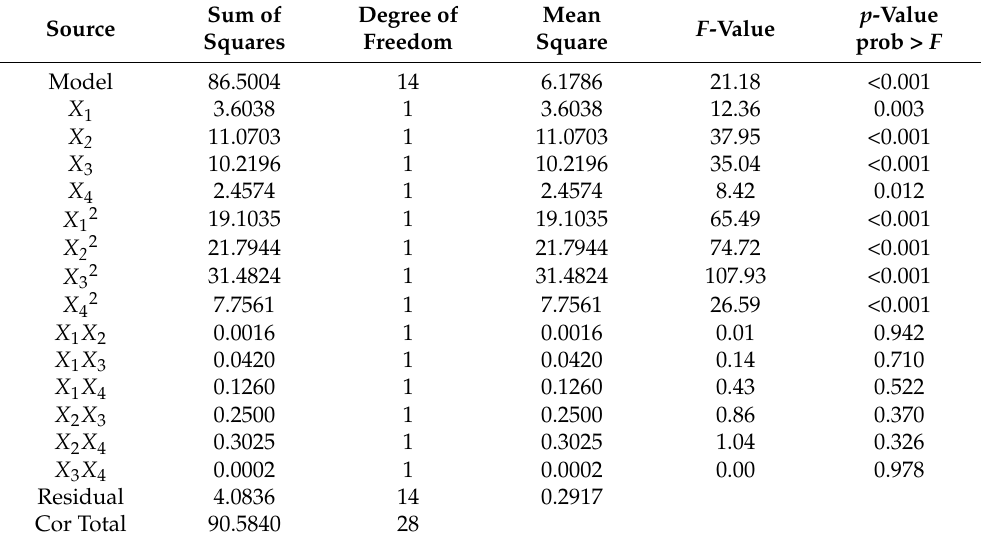
Table 3. ANOVA for response surface quadratic